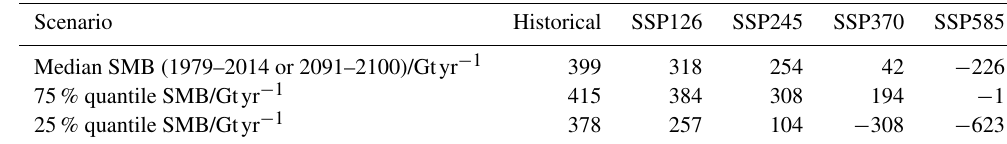
Table 1. Median and quartiles over all ESM and snow model parameter combinations of the 2091–2100 SMB mean value for different scenarios.